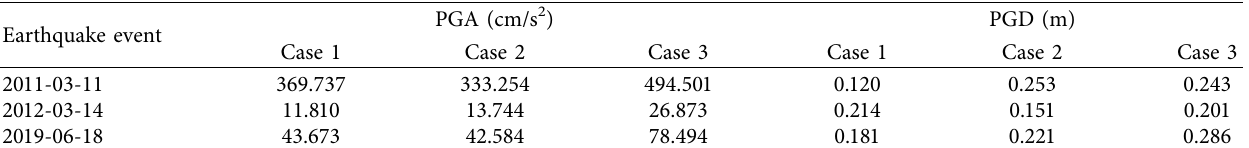
Figure 9: Horizontal displacement time history of the seabed or surface in the three earthquakes. (a) 2011-03-11. (b) 2012-03-14. (c) 2019- 06-18. Table 4: Peak acceleration and peak displacement of seabed or